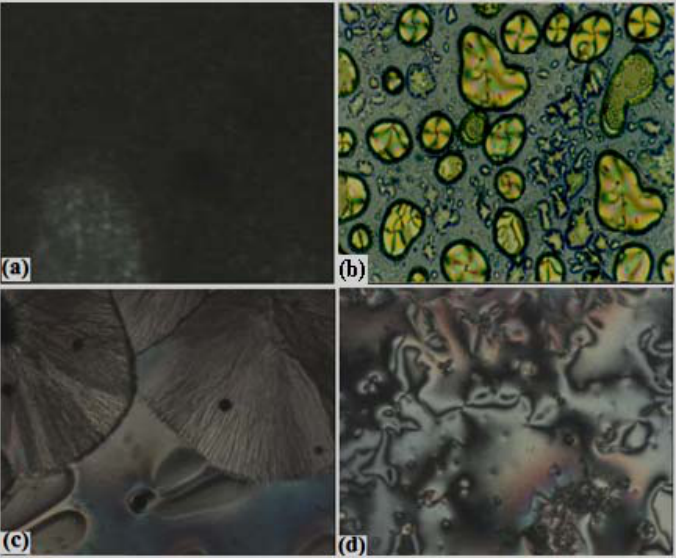
Figure 5. Polarized optical micrographs of (a) diol 2a , (b) diol 2b , (c) diol 2c , and (d) diol 2d